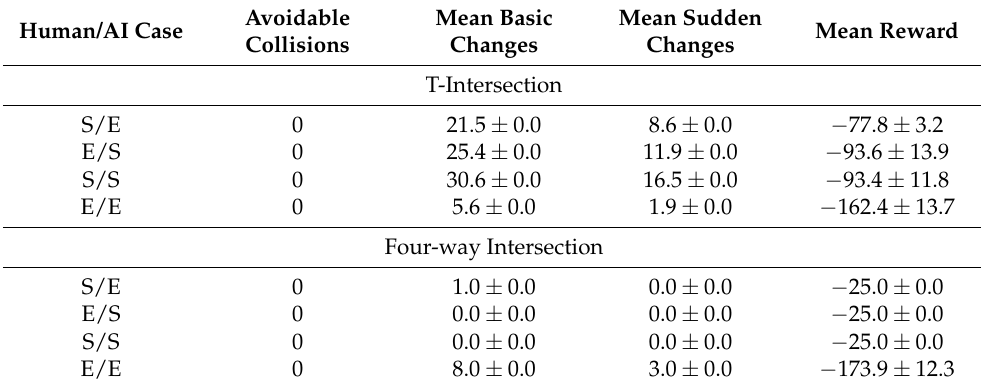
Table 13. Human: weather, AI: weather and color. Test results for manager performance and behavior. Human/AI